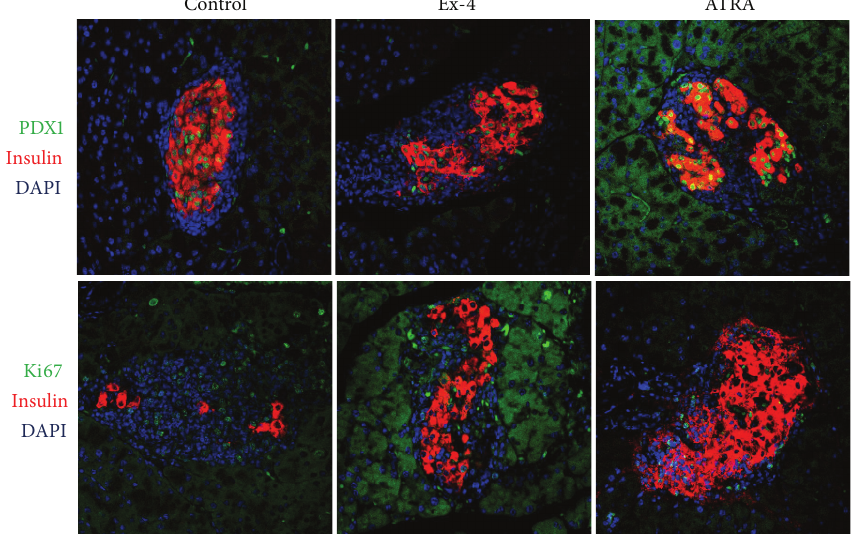
Figure 4: Insulin, Pdx-1, and Ki67 staining for islets in the pancreases of adoptive transferred NOD/scid mice treated with vehicle, ATRA, and exendin-4